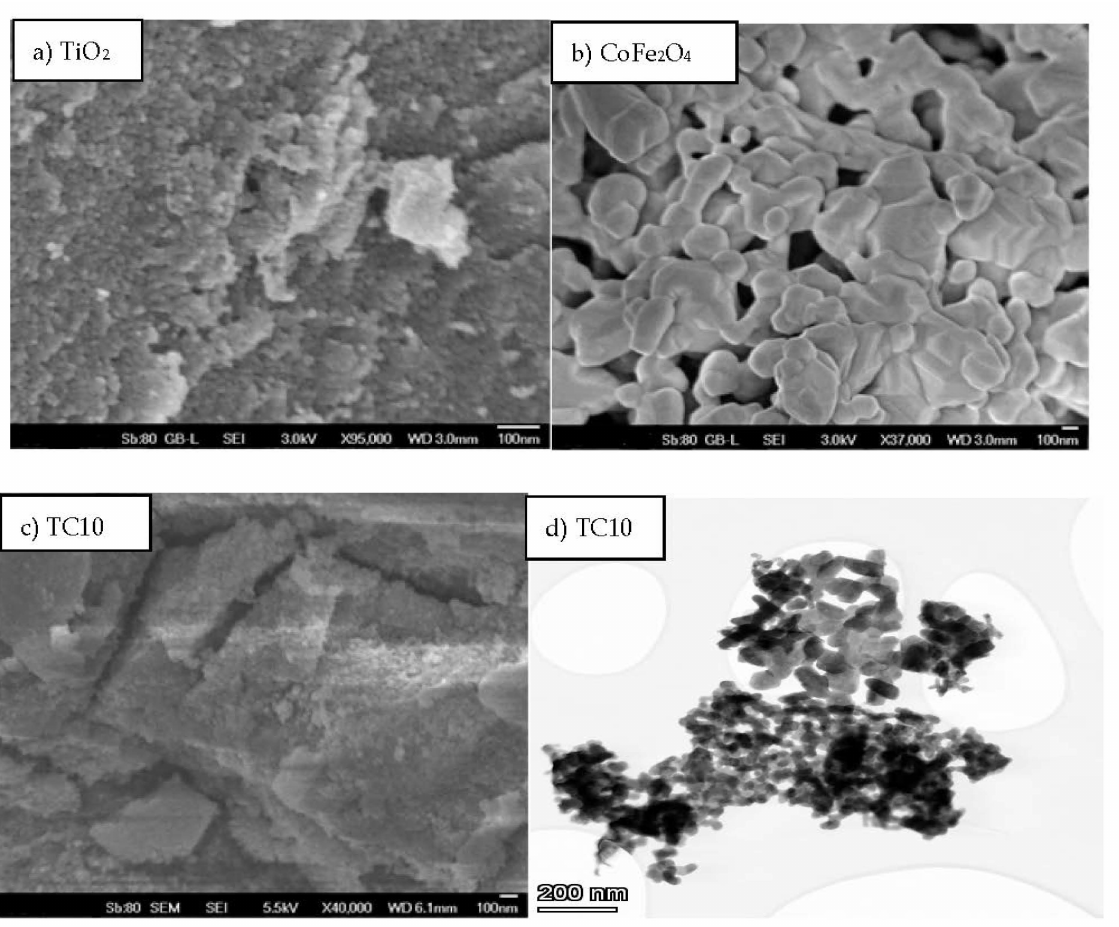
Figure 4. Microscopy-based analyses of the samples with SEM at 100 nm ( a – c ) and with TEM at 200 nm ( d